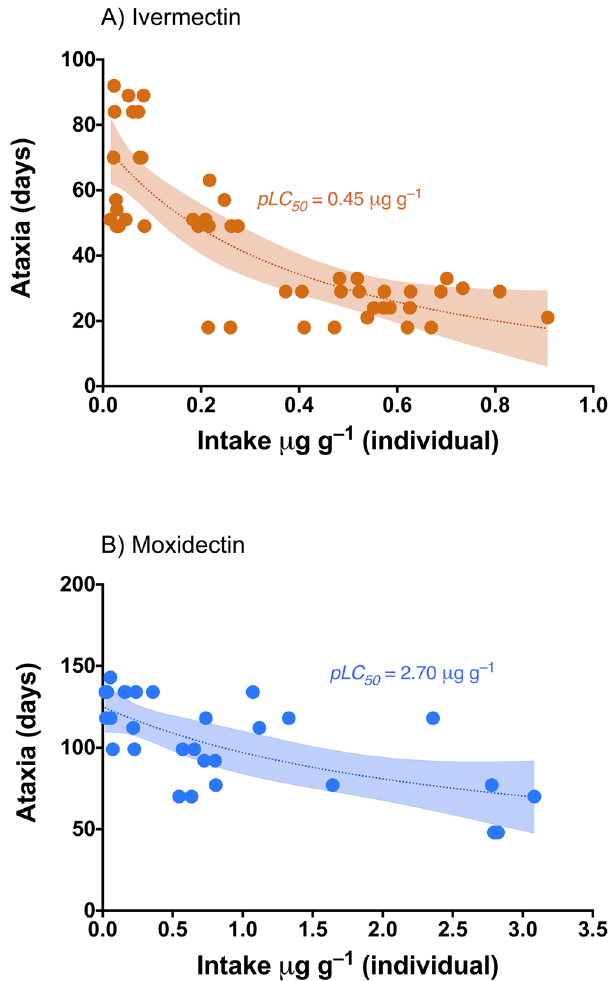
Figure 3. Total ingestion response curves for ataxia symptoms by ivermectin (IVM) ( A ) and moxidectin (MOX) ( B ). Shaded areas represent the 95% confidence intervals of each model. pLC 50 corresponds to the quantity of each ML ingested by beetles ( µ g of each ML/g of individual beetles) that provoked a response halfway between the minimum number of days and the maximum number of days that produced pre-lethal